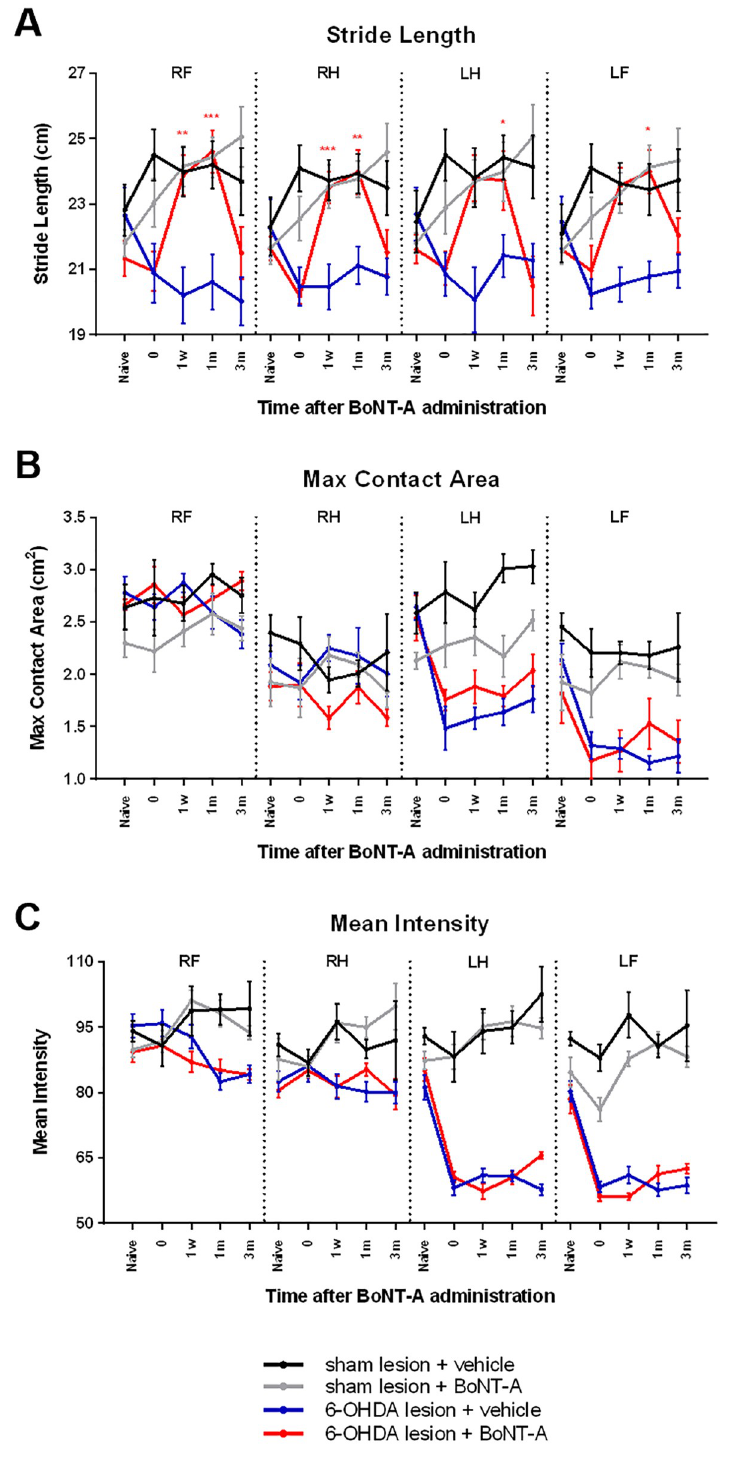
Fig 2. Static gait parameters unaffected by BoNT-A. Changes in static gait parameters measured by the CatWalk apparatus for each experimental group (n = 8 per group). Paws were measured individually (RF: right front, RH: right hind, LF: left front, and LH: left hind). Experimental timepoints are reflected on the x-axis: na ï ve rats tested prior to any surgeries, 6-OHDA (or sham infused) animals tested at timepoint 0, and BoNT-A (or vehicle) animals tested at 1